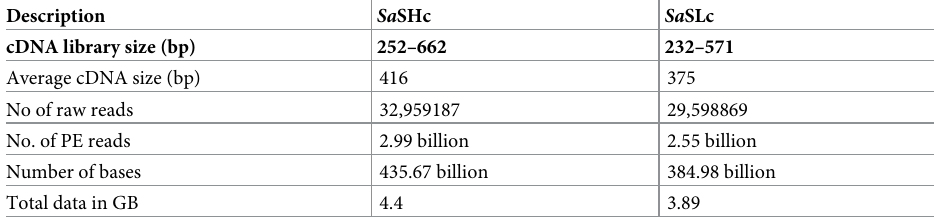
Table 1. Summary of cDNA library, RNA-Seq and de novo sequence assembly of combined ( Sa SHc and Sa SLc) S . album